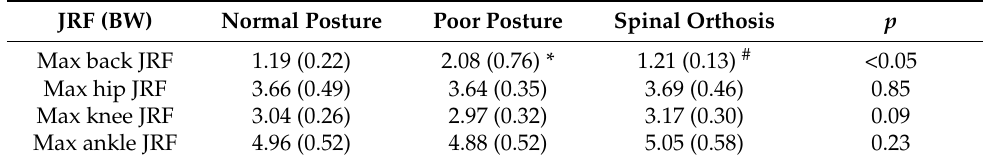
Figure 6. Joint reaction forces (mean and standard deviation) during the gait cycle when walking in normal posture, poor posture, and spinal orthosis. Table 3. Statistical analysis of the maximum JRFs during the gait cycle (mean ±